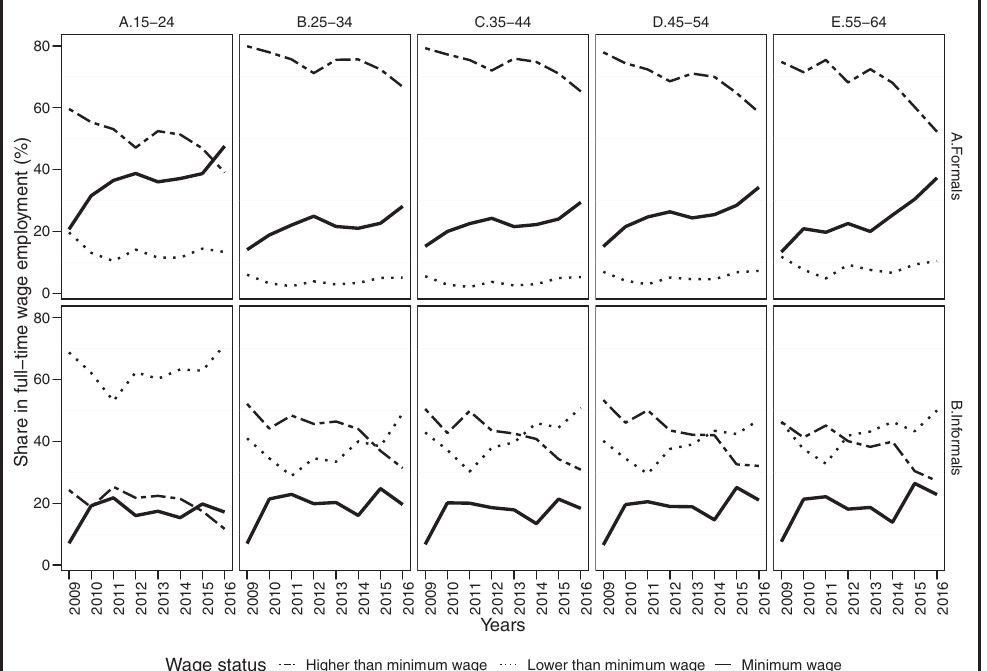
Figure A2 Share of minimum wage workers in formal and informal sectors by age